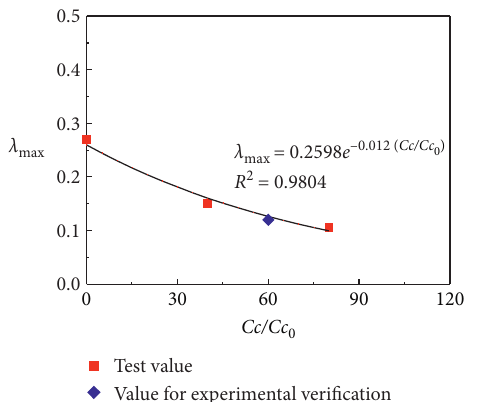
Figure 14: Relation of λ